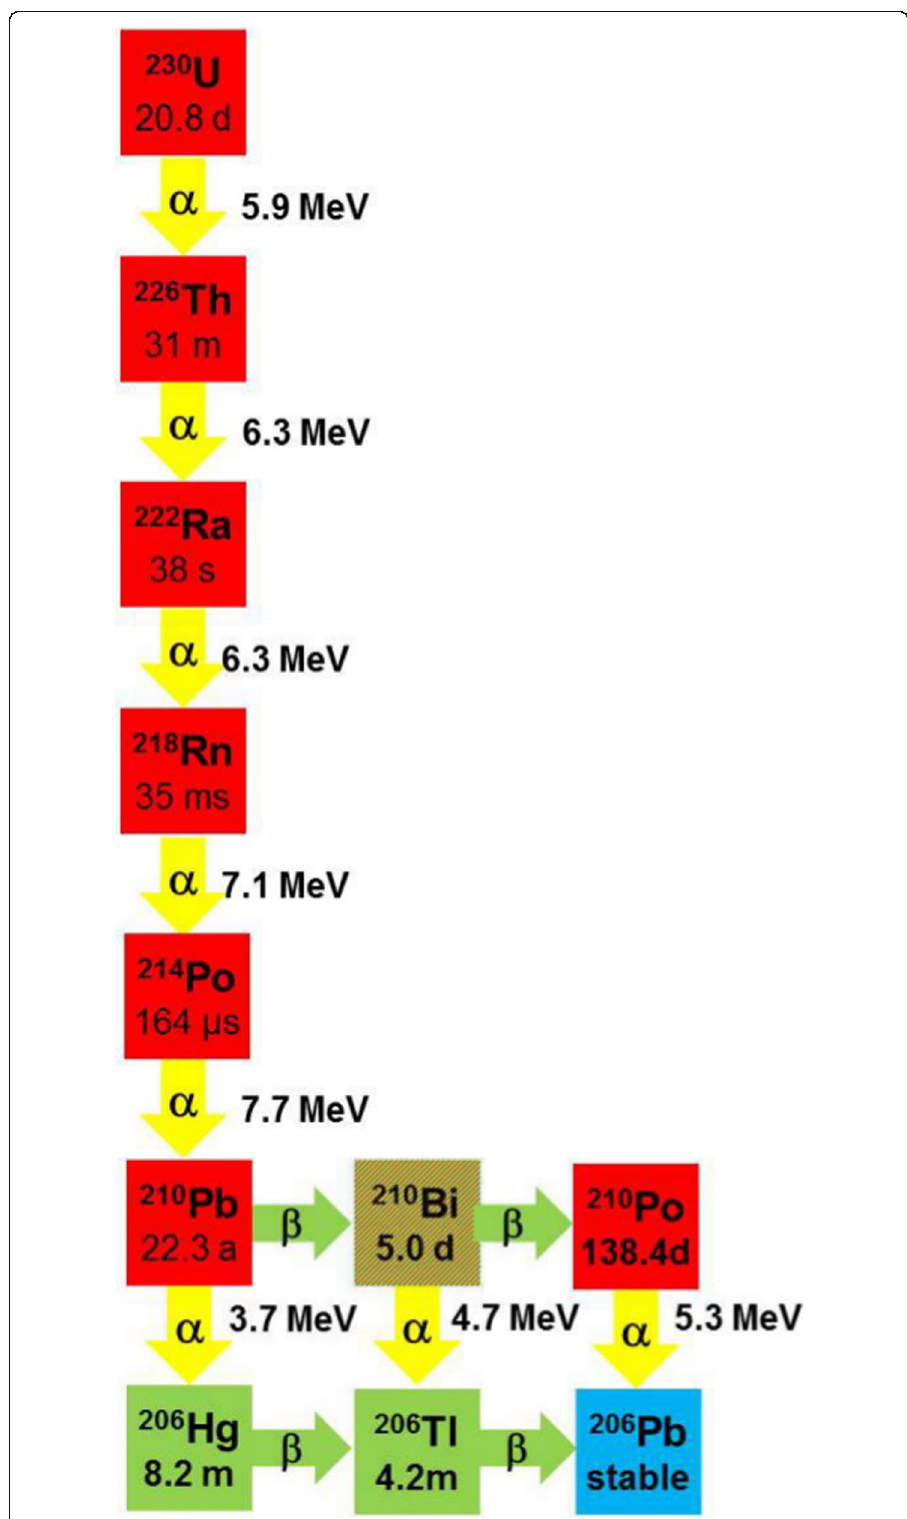
Fig. 1 230 U decay scheme (Data retrieved from J. Magill, G. Pfennig, J. Galy (2006), Karlsruher Nuklidkarte, 7th ed.; Haberbeck GmbH,